Question: What direction does the quantity move in — increasing or decreasing?
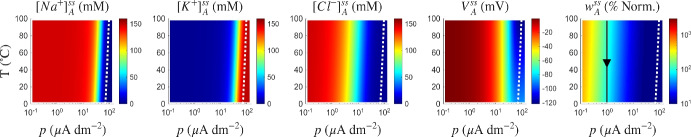
Answer: decreasing